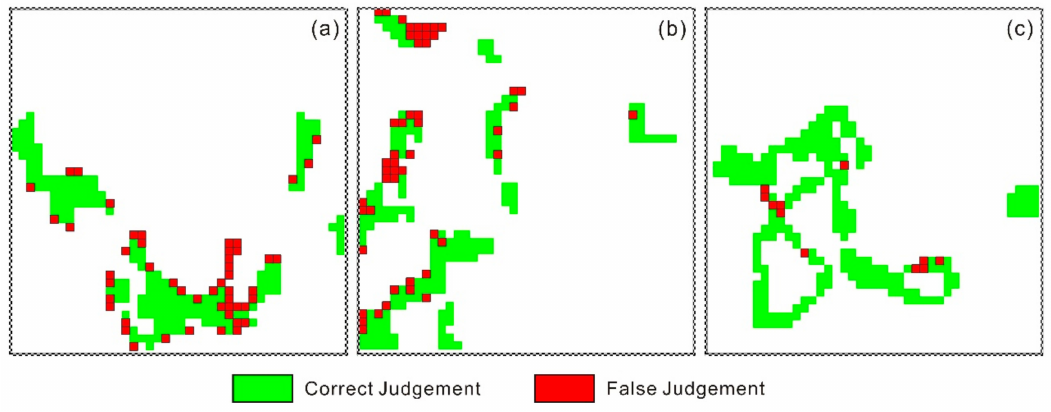
Figure 9. The feature space performed in ( a ) mild, ( b ) moderate, and ( c ) severe pollution